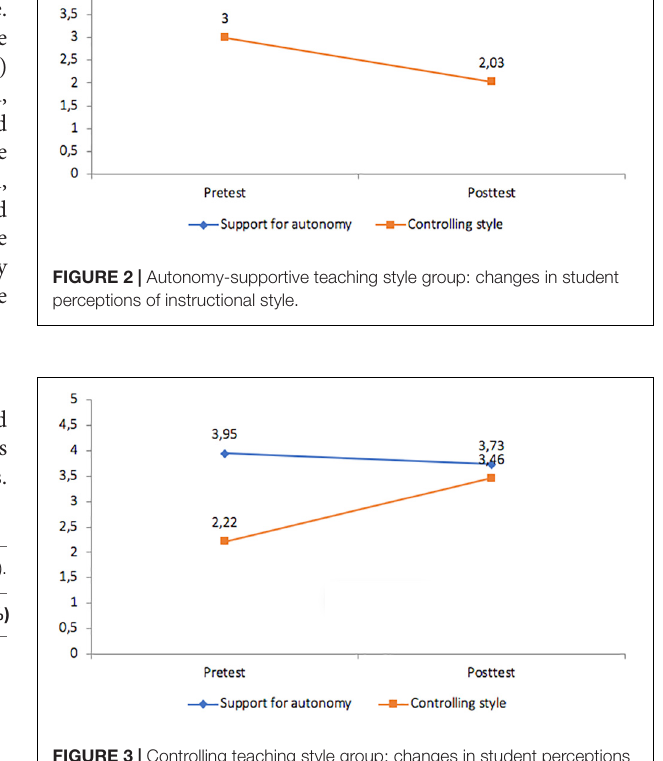
FIGURE 3 | Controlling teaching style group: changes in student perceptions of instructional